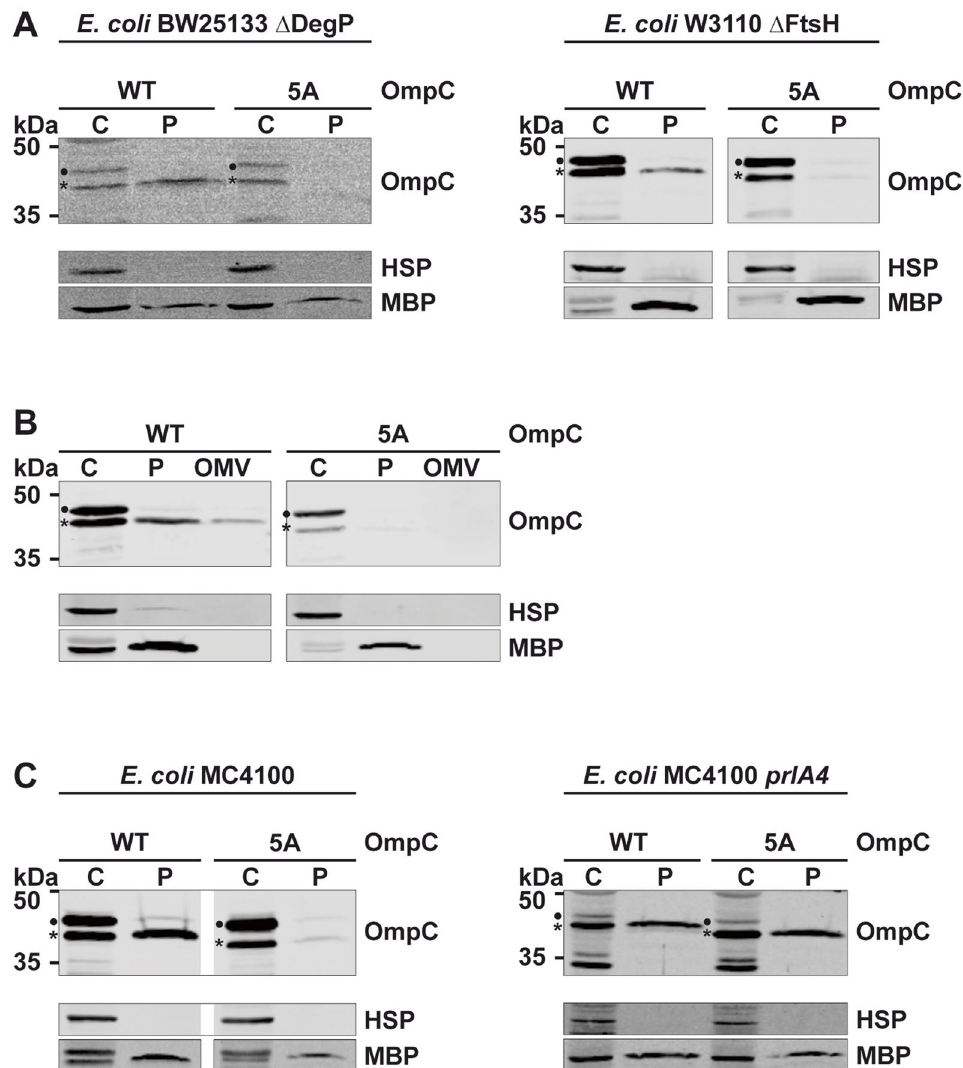
Figure 5. A proof-reading activity of SecY prevents translocation of OmpC with a mutated pore domain. ( A–C ) Transformed E. coli cells expressing the proteins indicated were fractionated and the cytoplasmic (C) and periplasmic (P) fraction analyzed by Western blotting. Unprocessed full length constructs ( after signal peptide cleavage (*) are marked. Cytosolic heat shock proteins (HSP) and the periplasmic maltose- binding protein (MBP) were analyzed in parallel. ( A ) The indicated constructs were expressed in E. coli mutants devoid of either the periplasmic protease Degp (left panel) or FtsH, an integral membrane protease of the inner membrane (right panel). ( B ) Outer membrane vesicles (OMV) were prepared from E. coli cells expressing OmpC or OmpC-5A and analyzed by Western blotting. The cytosolic (C) and periplasmic (P) fractions were analyzed in parallel. ( C ) Expression of OmpC and OmpC-5A was analyzed by Western blotting in an E. coli mutant strain harboring the prlA4 mutation in SecY (right panel). The corresponding wildtype strain (MC4100) was analyzed in parallel (left panel). Uncropped images of representative Western blots can be found in Supplementary Figures 5 and